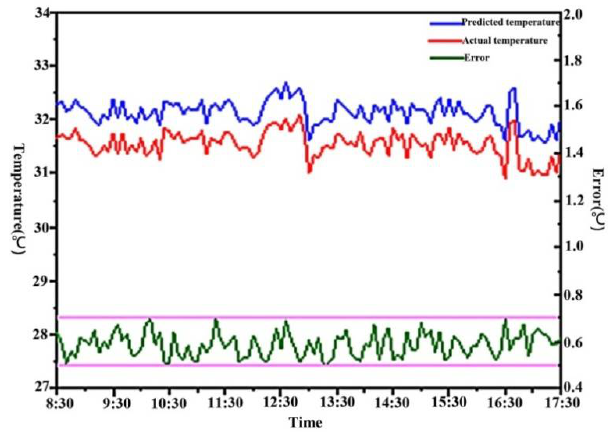
Figure 7. The cooling water outlet temperature of chiller predicted by the module.